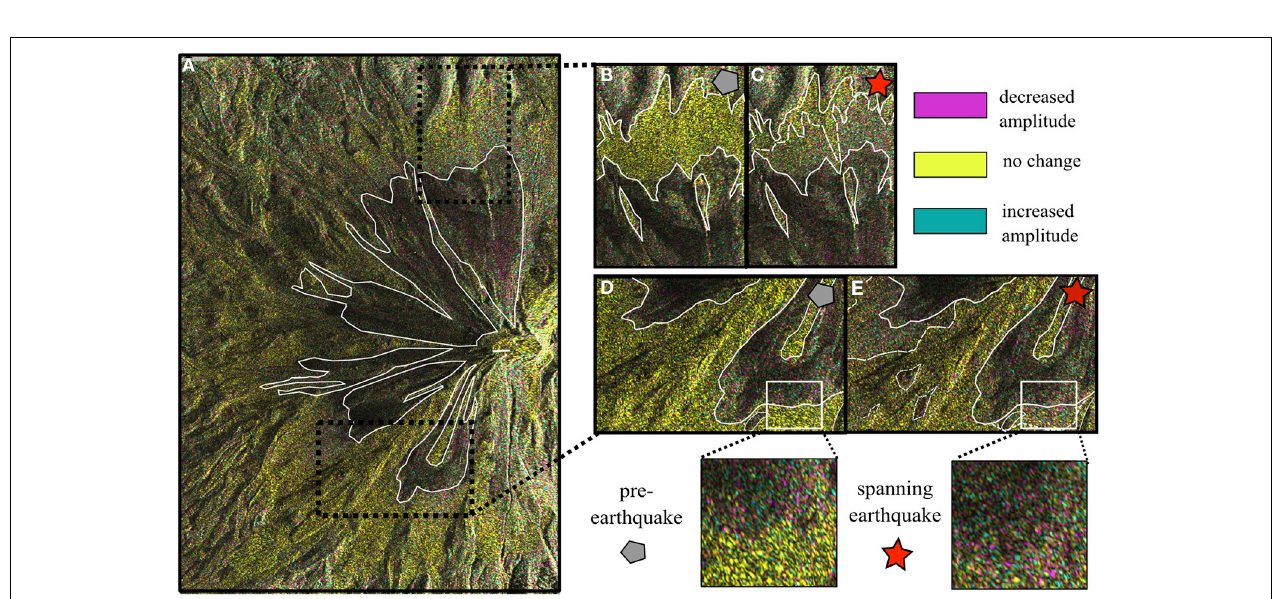
identifiable in all interferograms, dashed lines show boundaries identified from at least two images. (B) Topographic map of Arenal, showing elevation above sea level and areas of topographic change since the SRTM DEM was acquired in 2000 (pale outlines).